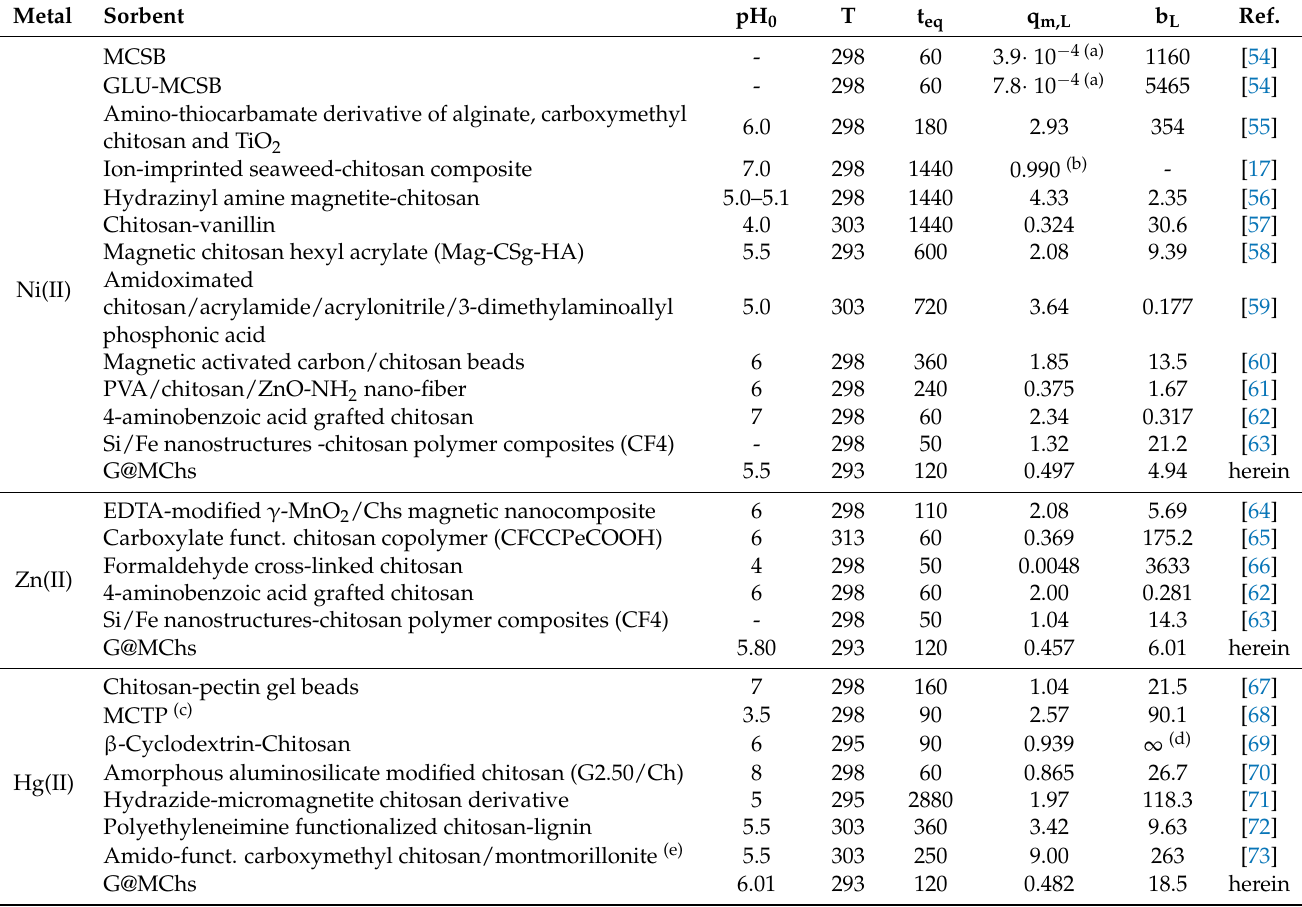
Table 4. Comparison of Ni(II), Zn(II) and Hg(II) sorption properties (temperature, T, K; t eq , min; q m,L , mmol g − 1 ; b L , L mmol − 1 ) for alternative chitosan-based